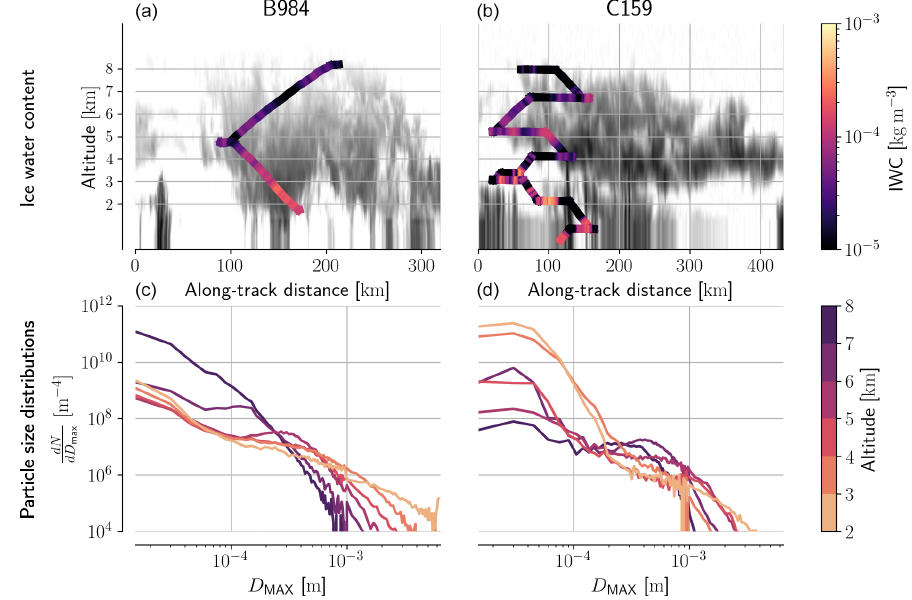
Figure 7. In situ-measured IWC and PSDs for flights B984 and C159. The first row of panels displays the measured IWC along the flight path plotted on top of the co-located radar observations. The second row displays the variation of the mean of the in situ-measured PSDs for different altitudes in the